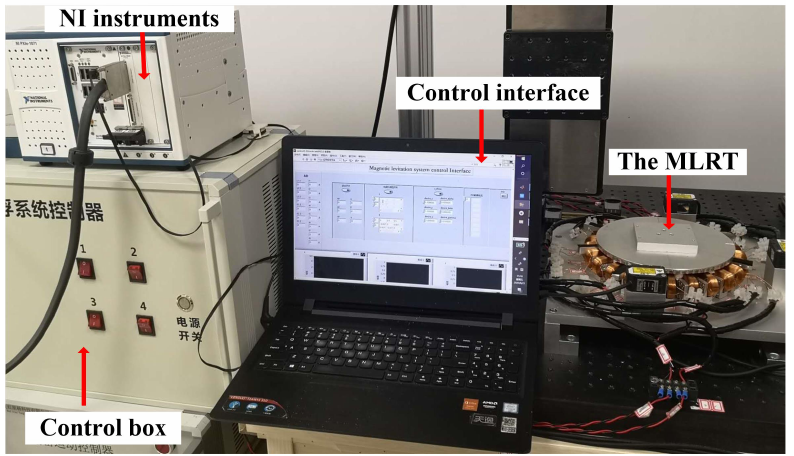
Figure 3. Experimental